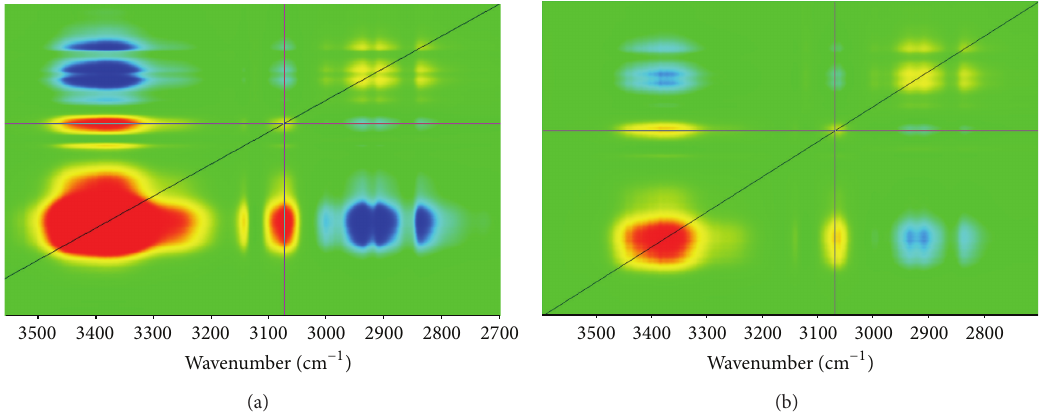
Figure 6: Two-dimensional FTIR correlation analysis of cellulose in AMIMCl solution. Synchronous spectrum on heating (a) and cooling (b). Spectral range 2700 to 3600 cm −1 .